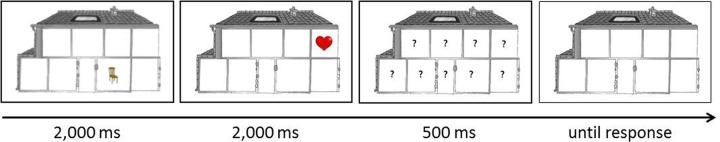
Example of a trial (N = 2) taken from the short-term feature-binding task adapted from Picard et al. (2012).